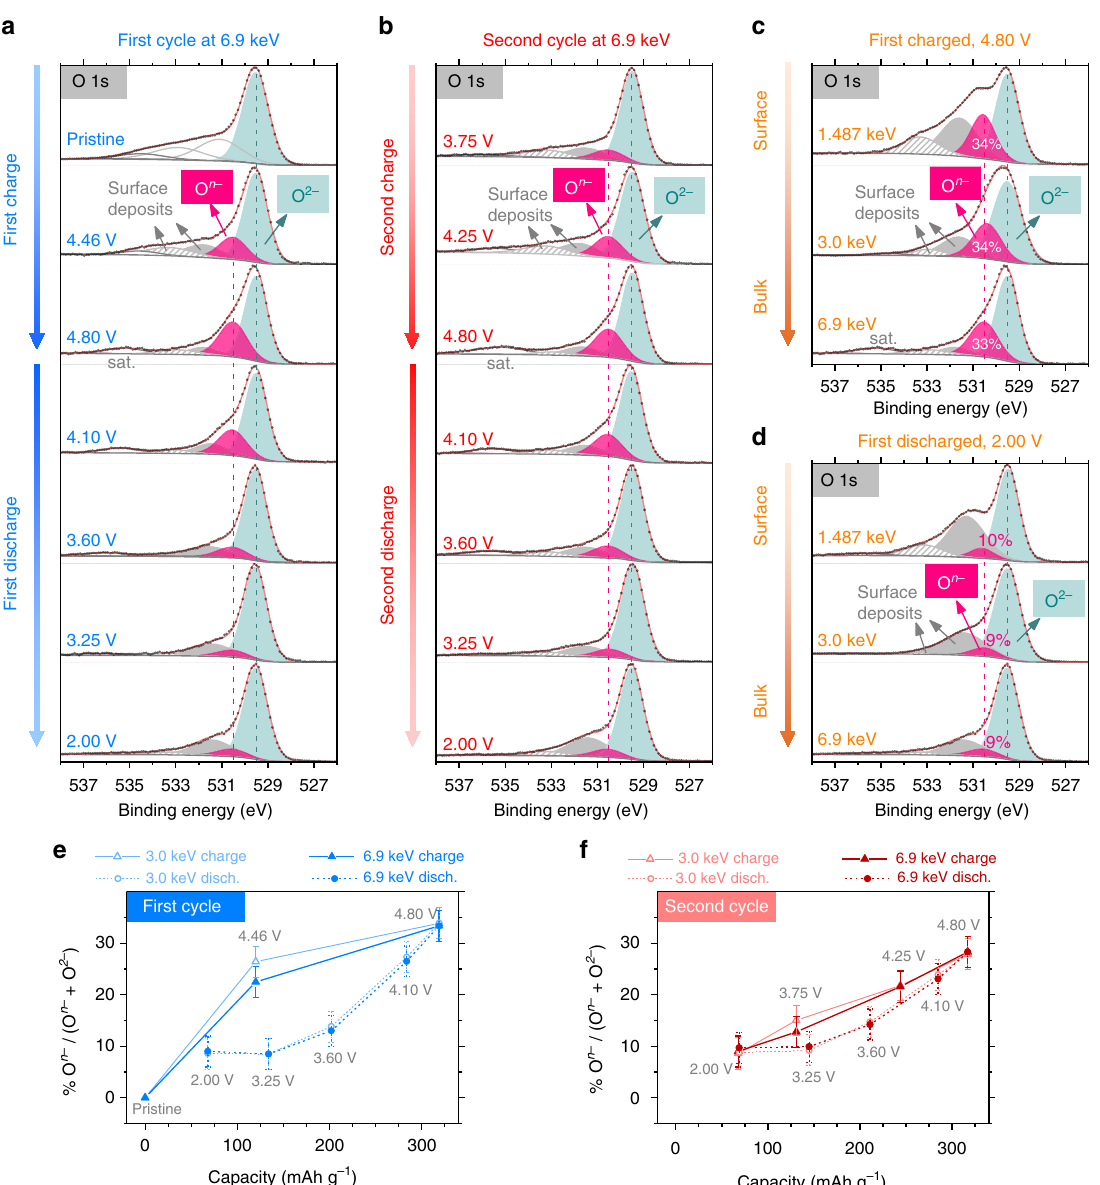
Fig. 2 Charge compensation from oxygen (anionic redox) as deduced by HAXPES. Evolution of O 1 s photoelectron spectra at 6.9 keV (highest probe depth) during the a fi rst and b second cycles. Black dots are experimental data and red curves are fi ts. Lattice O 2 – peak is at binding energy (BE) ≈ 529.5 eV. On charge, oxidized lattice oxygen, O n – grows at BE ≈ 530.5 eV (pink peak) followed by its reduction on discharge. Surface deposits appear at higher BEs (gray peaks). Each O 1 s panel has been normalized to keep the same intensity of the O 2 – component (green peak) for all spectra. Note that the pristine sample was never in contact with the electrolyte and that its oxygenated surface species are those commonly observed at the surface of oxides. The other samples are electrochemically prepared and hence show new surface oxygenated species compared to the pristine, which come from electrolyte decomposition and passivating surface fi lm formation. An extra satellite peak at BE ≈ 535 – 536 eV is seen with 6.9 keV (and also weakly with 3.0 keV). The effect of probe depth on the O 1 s spectra is shown for two samples, c fi rst charged at 4.80 V and d fi rst discharged at 2.00 V. Surface deposits diminish at high